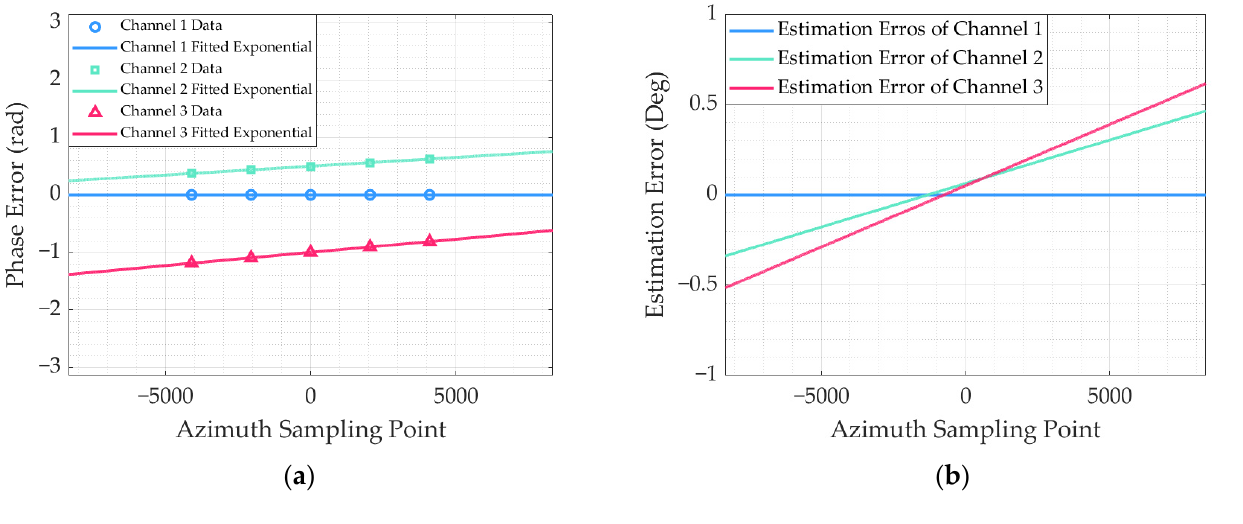
Figure 12. Azimuth time-variant phase error estimation results. ( a ) Azimuth chunking estimation and least-squares fitting results ( b ) Estimation error of azimuth linear time-variant phase.